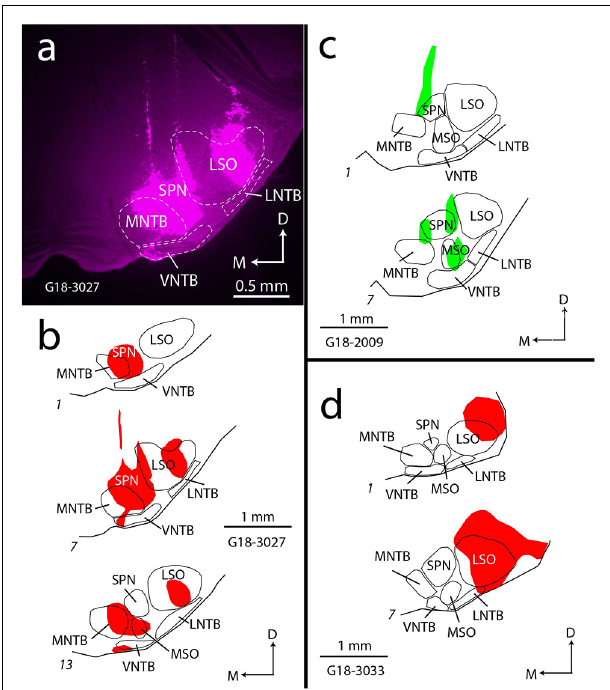
FIGURE 1 | Examples of RetroBead injections in the SOC. (A) Photograph showing multiple deposits of red RetroBeads (magenta) in the SOC of case G18-3027. (B) Drawings depicting the rostro-caudal extent of the red RetroBead injection in case G18-3027. Section 7 corresponds to the photograph in panel (A) . This injection included most major SOC nuclei. In this and subsequent panels, sections are arranged from caudal (section 1) to rostral. (C) Drawings depicting the extent of the green RetroBead injection in case G18-2009. The deposits, in this case, were located in central parts of the SOC. (D) Drawings depicting the extent of the green RetroBead injection in case G18-3033. This deposit included only lateral parts of the SOC. Abbreviations: D, dorsal; LNTB, lateral nucleus of the trapezoid body; LSO, lateral superior olivary nucleus; M, medial; MNTB, medial nucleus of the